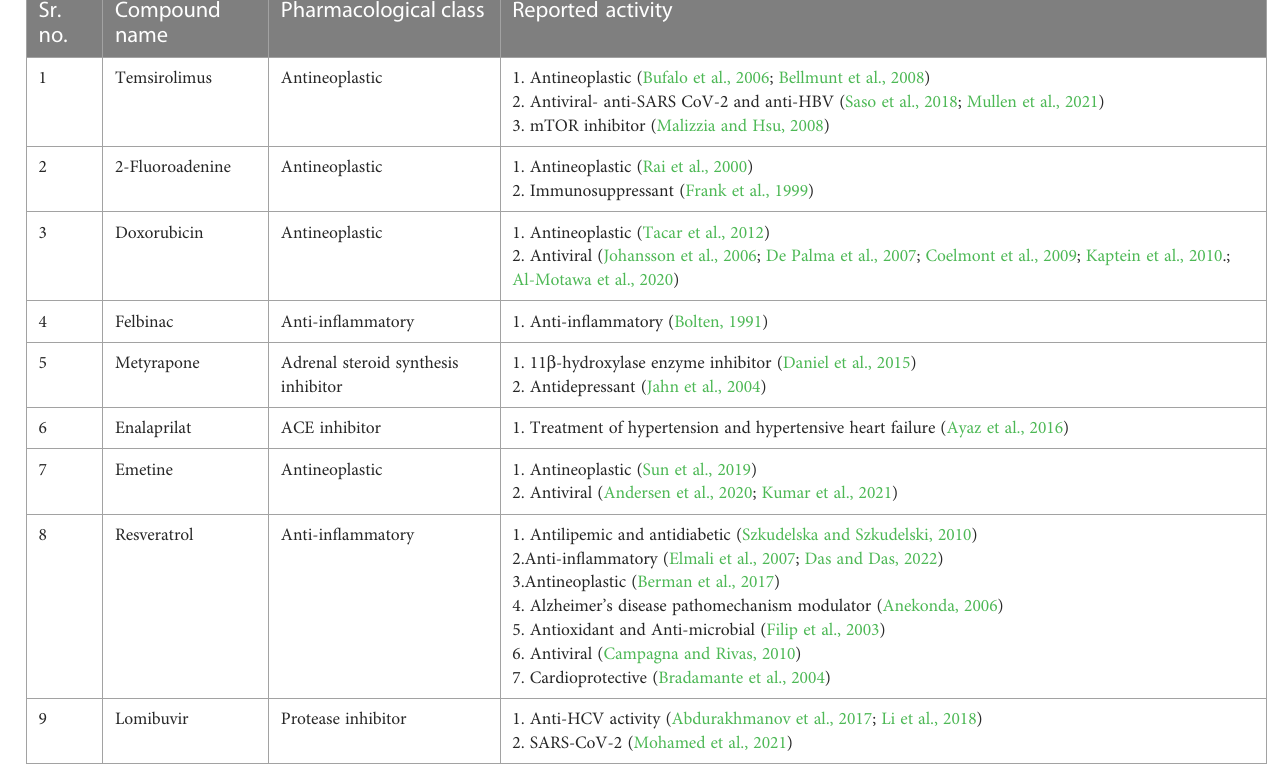
TABLE 1 Pharmacological characteristics of the investigated FDA-approved drugs. Sr.